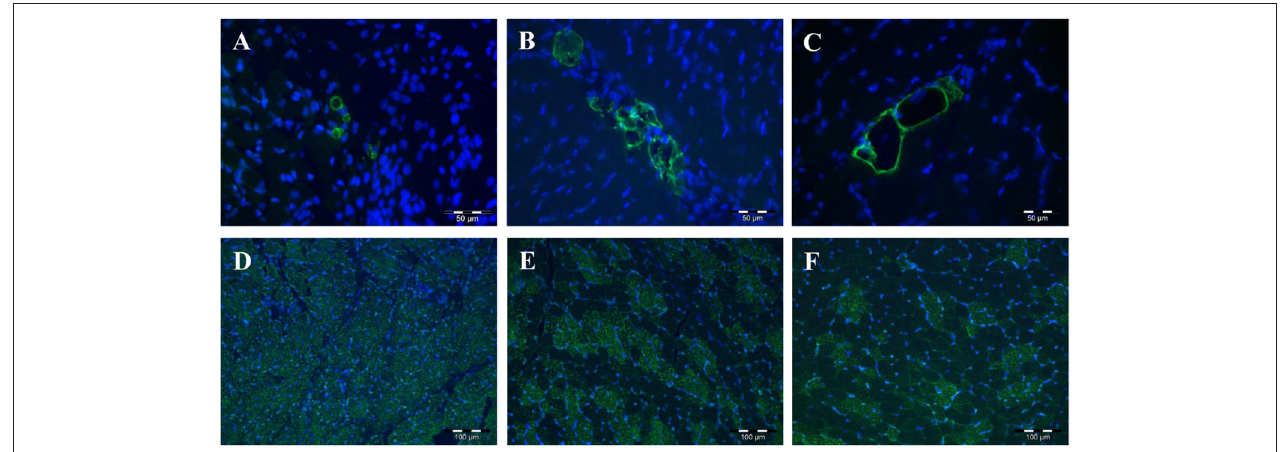
FIGURE 4 | Immunohistochemical localization of PLIN3 (A,B) , PLIN4 (C,D) , and PLIN5 (E,F) in porcine M. longissimus at 12 dpn. Nuclei were counterstained blue with Hoechst 33258. The right panel shows merged images of fluorescence (PLIN and Hoechst 33258) and bright field.